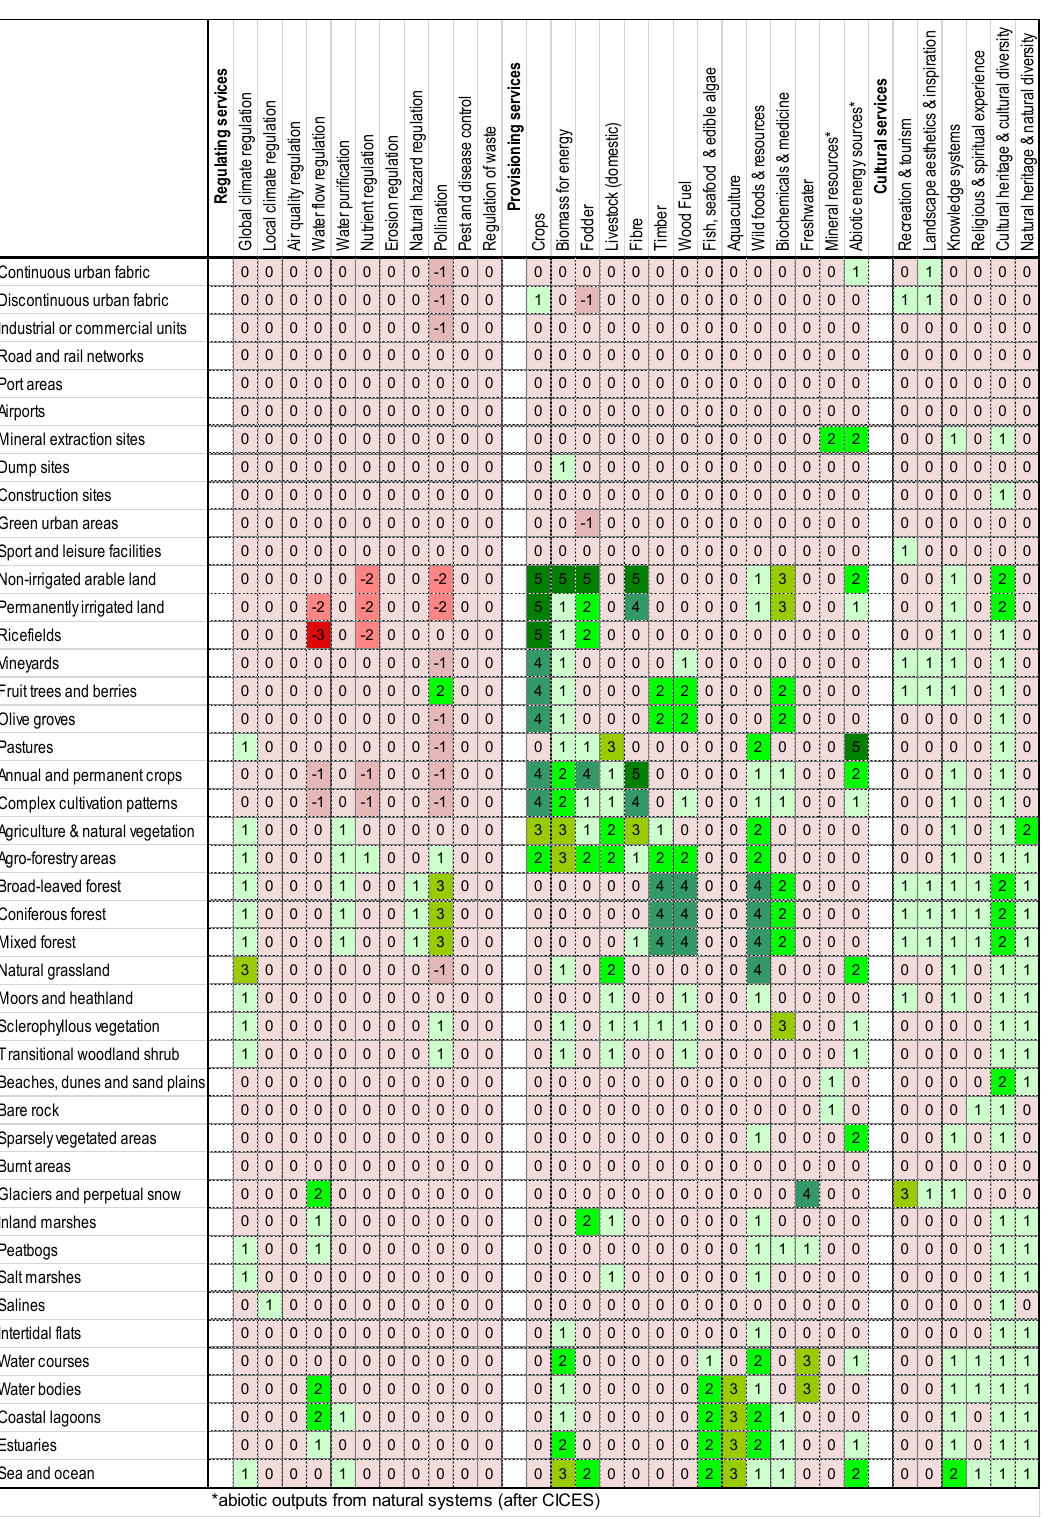
Figure 6: Exemplary ecosystem service potential - flow comparison matrix. The evaluations’ (from Figures 4 and 5) comparison refers to a hypothetical European „normal“ landscape in summer (before the harvest period). Scale from −5/brown red = flow (actual use) exceeds potential (potential supply) significantly; via 0/rosy = flow = potential; to 5/dark green = potential exceeds flow